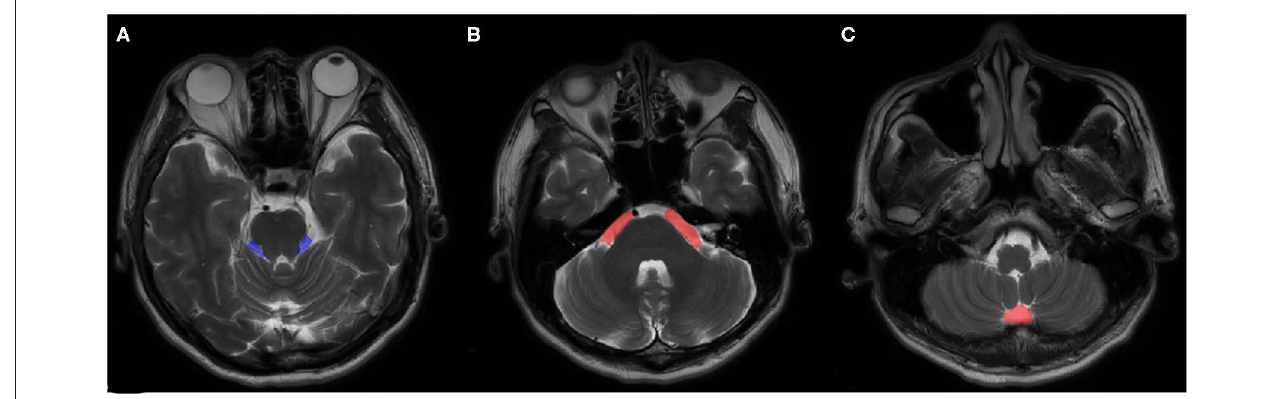
FIGURE 1 | An example of ROI views on MRI. (A) cerebellopontine cisterns, (B) precerebellar cistern, (C) prespinal